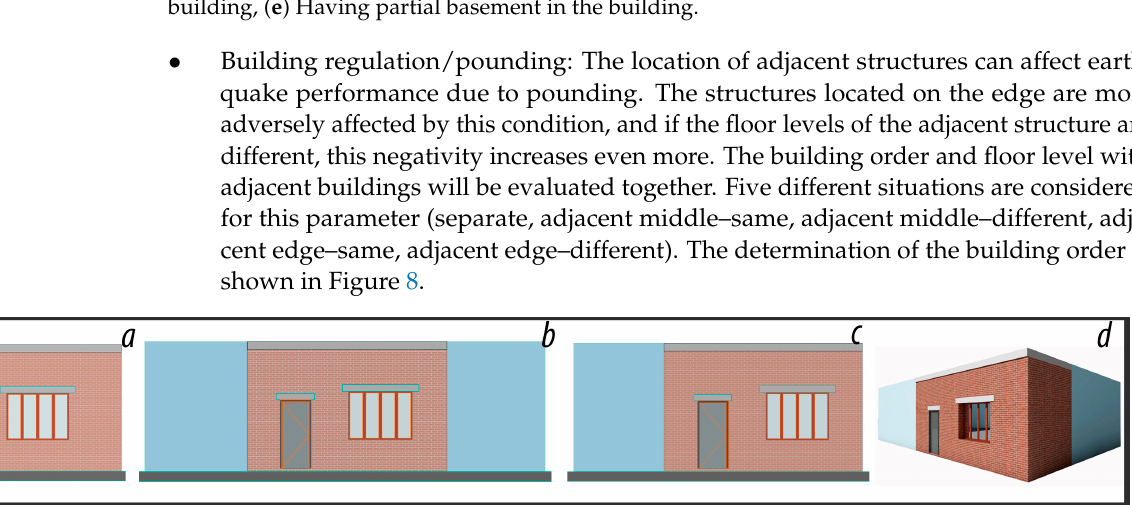
Figure 9. Floor levels in adjacent buildings: ( a ) Same, ( b )Same (Limit condition), ( c ) Different. • Current situation and visual quality: Material type, quality, and masonry construc- tion work will be checked separately and classified as good, moderate, and bad. In addition, it will be determined whether there is damage to the existing structure. • Irregularity in plan: Irregularity in the plan is determined in three different ways: regular, irregular, and extremely irregular according to the plan geometry. The dif- ferent situations related to this are shown in Figure 10. Figure 10. Examples of irregularity in plan: ( a ) Regular, ( b ) Irregular, ( c ) Regular, ( d ) Irregular, ( e ) Extremely irregular. • Insufficient wall quantity: Facade wall length in both perpendicular directions will be determined on the critical floor (usually the ground floor) of the building, as shown in Figure 11. Accordingly, the number of walls (DM) in the building is high if the length of the door and window openings on the front or side facades on the ground floor is less than 1/3 of the facade length, and medium if the length of the gaps is between 1/3 and 2/3 of the facade length. If the length of the gaps is more than 2/3 of the facade length, it will be considered low. Calculations for the wall quantity are shown in Table 7.